Question: Does the figure show an increasing or a decreasing trend?
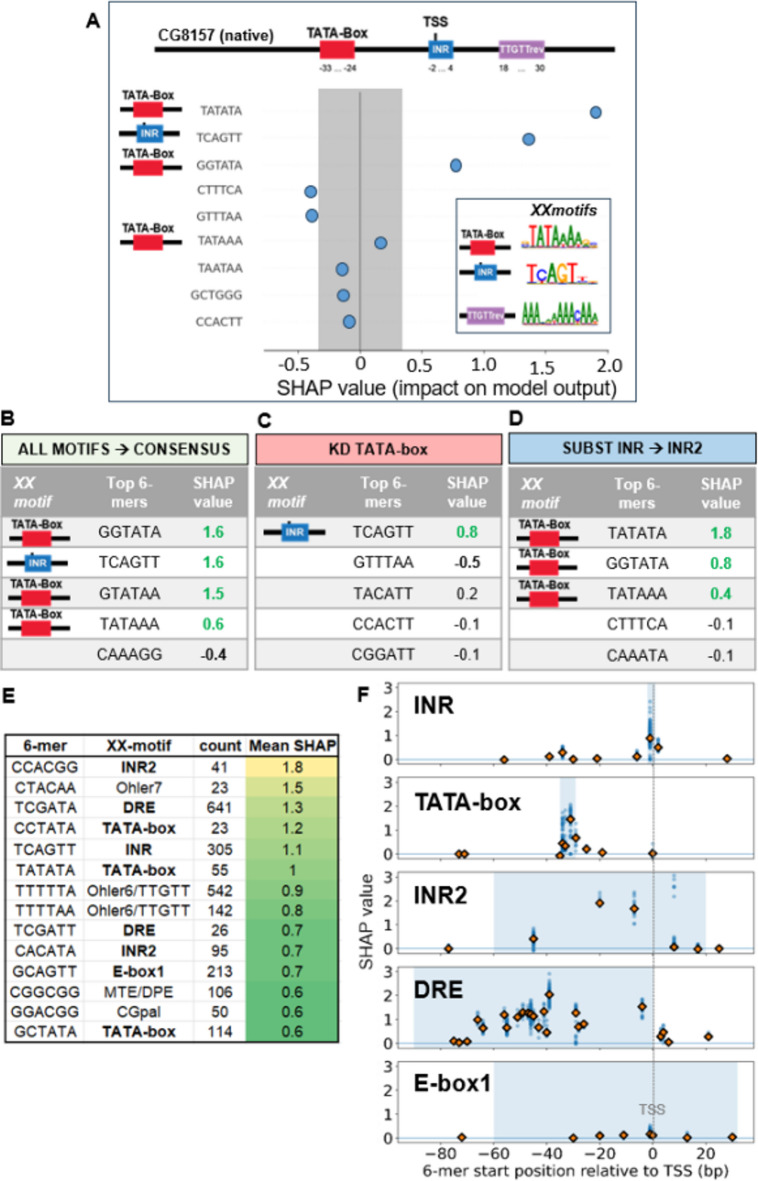
Answer: increasing